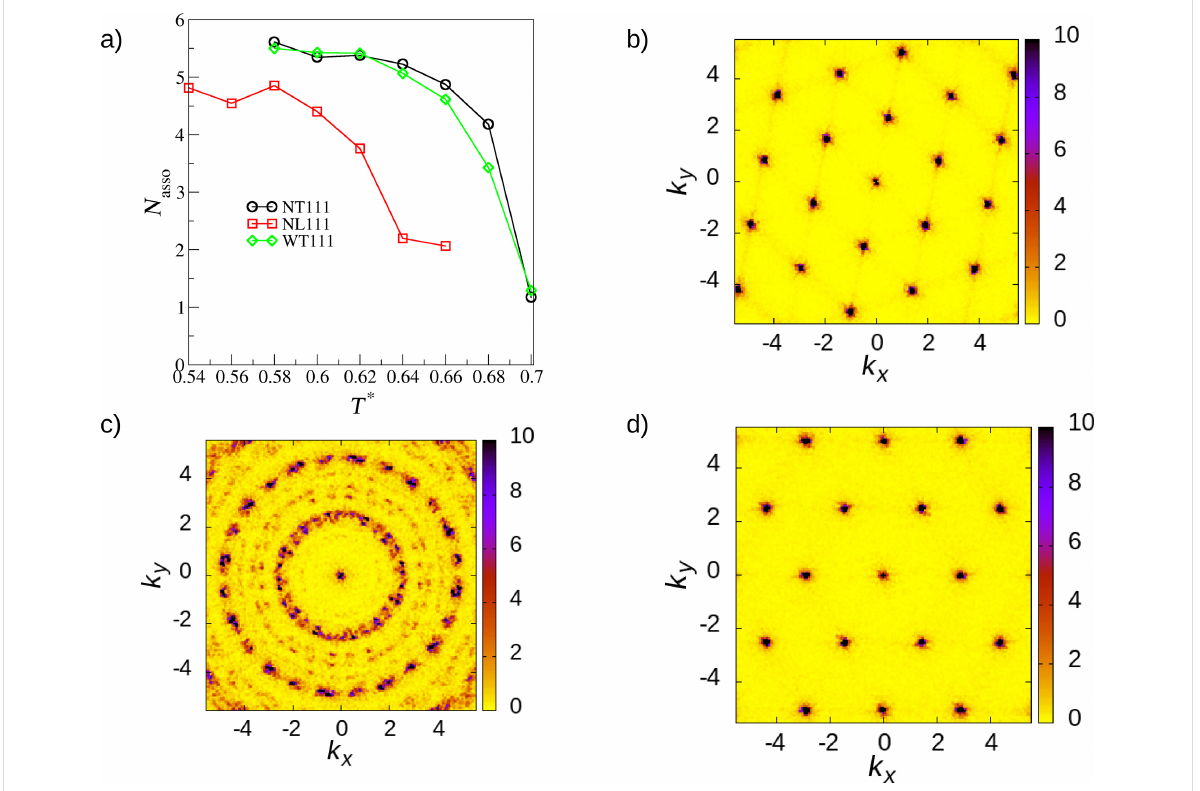
Figure 3: a) Average association number N asso as a function of the temperature. b–d) Structure factors calculated for the central segment for the systems NT111 at T * = 0.58, NL111 at T * = 0.54, and WT111 at T * = 0.58, respectively, all with ρ * = 0.2.